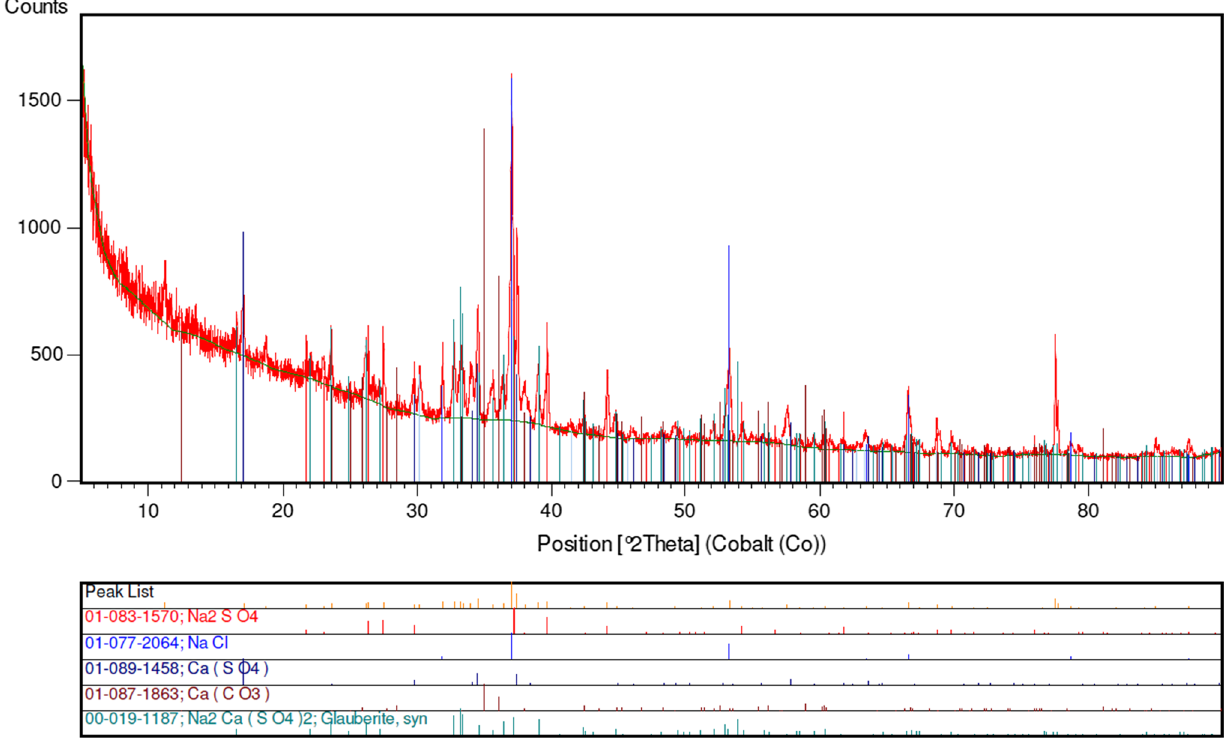
Fig. 7 XRD analysis of the crystals produced from the desalination of RO brine